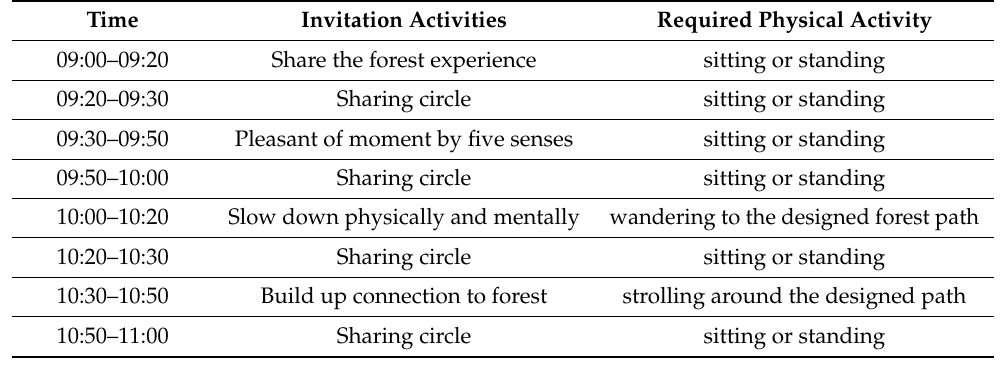
Table 1. Schedule of each forest visit.